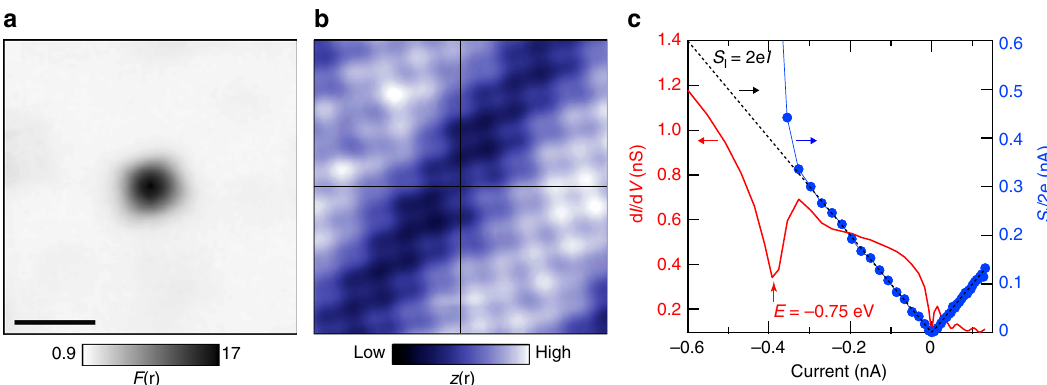
Fig. 2 General characteristics of noisy defects. a Average current-noise image constructed from 44 defects in Fig. 1d. The scale bar indicates 1 nm. b Average topographic image corresponding to ( a ). The clear atomic contrast indicates that the defects are all located at roughly the same location, i.e. in between four Bi atoms. c Typical differential conductance spectrum plotted versus the current (solid red, left axis, E setup = − 1 eV, the dip is located at E = − 0.75 eV) and simultaneously recorded noise (blue markers and line, right axis): the drop in differential conductance is strongly correlated with the deviation of the noise from Poissonian (dashed line)